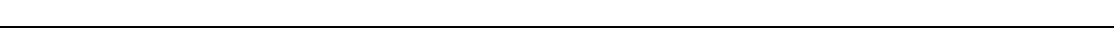
Fig. 1 Clustering of single RGCs based on the transcriptomes. a Representative image of P5 RGCs immunostained for RGC marker RBPMS and neuronal marker Tuj1, at 12 h in culture after immunopanning (Scale bar, 50 µ m). b Coverage depth of 5000 genes per cell, on average, was achieved. A sub-peak below 3000 genes per cell was excluded due to poor coverage (a cutoff threshold is indicated by a dashed line). c Correlation analysis of gene expression in population of RGCs, as inferred from the scRNA-seq pro fi ling of RGCs (by averaging gene expression from all the cells), and as determined through bulk full-length mRNA-seq of pooled RGCs (Pearson r = 0.86, 2-tailed, p < 0.0001; fi t line by LOESS). d RGC clusters were identi fi ed based on their transcriptome signatures and visualized using CellRanger and CellView pipeline (see Methods section for details). The t-SNE 2D graph, with the 3rd dimension color-coded, shows clusters distribution. e RBPMS is highly expressed in all RGC clusters, and in a similar proportion between left and right eyes across all the clusters. f Unsupervised k -means clustering heatmap and hierarchical clustering dendrogram of 6225 single RGCs gene expression pro fi les. The vertical distances on each branch of the dendrogram represent the degree of similarity between RGC clusters gene expression pro fi les. Expression level is color-coded; scale bar is NE log10-transformed following an addition of a pseudocount. g Distribution of RGC clusters from less to more similar (left to right) based on mean correlation coef fi cient between each cluster and every other cluster (mean ± SEM shown, Pearson r , 2-tailed). h Average percent of genes detected in RGC clusters ( y -axis) across increasing expression thresholds ( x -axis) relative to all genes that are expressed > 0 NE either within RGC homogeneous (expressed within 1.5-fold differences between any two clusters) or non-homogeneous (expressed> 1.5-fold difference between at least one cluster and another) genes and TFs categories (mean ± SEM shown; normalized separately within each category for comparison). In all the panels, cluster 0 represents RGCs which did not fi t uniquely to any one cluster but expressed RGC markers and were highly correlated with other